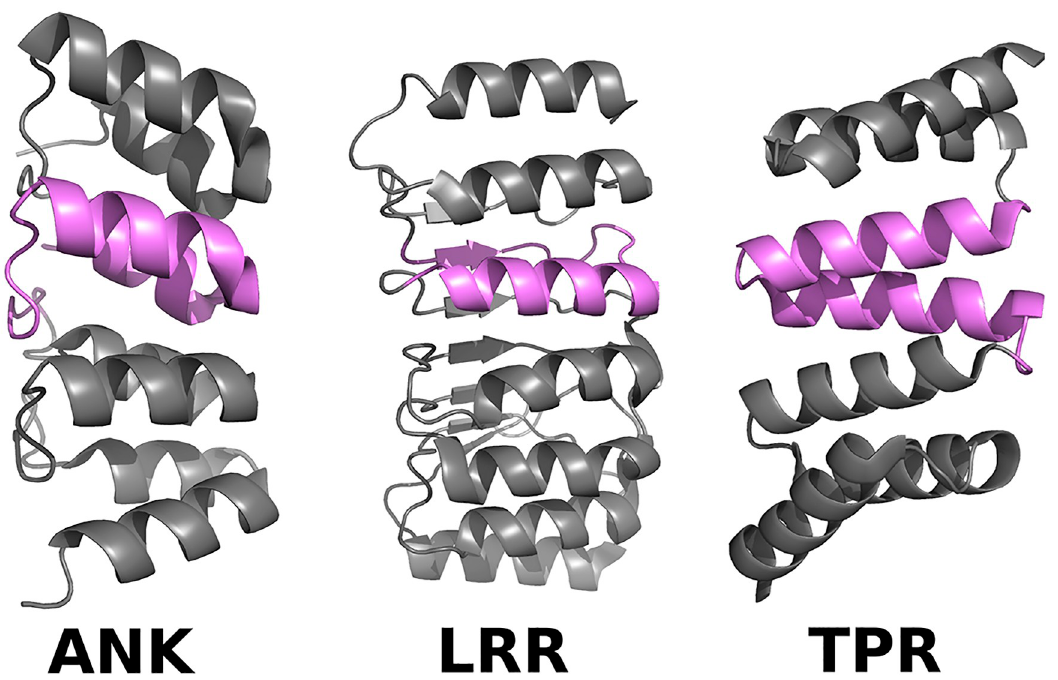
Fig 1. Repeat proteins fold into characteristic accordeon-like folds. Example structures of three protein families are shown, ankyrin repeats (ANK), tetratricopeptide repeats (TPR), leucine-rich repeat (LRR), with the repeating unit highlighted in magenta. All show regular folding patterns with defined contacts in and between